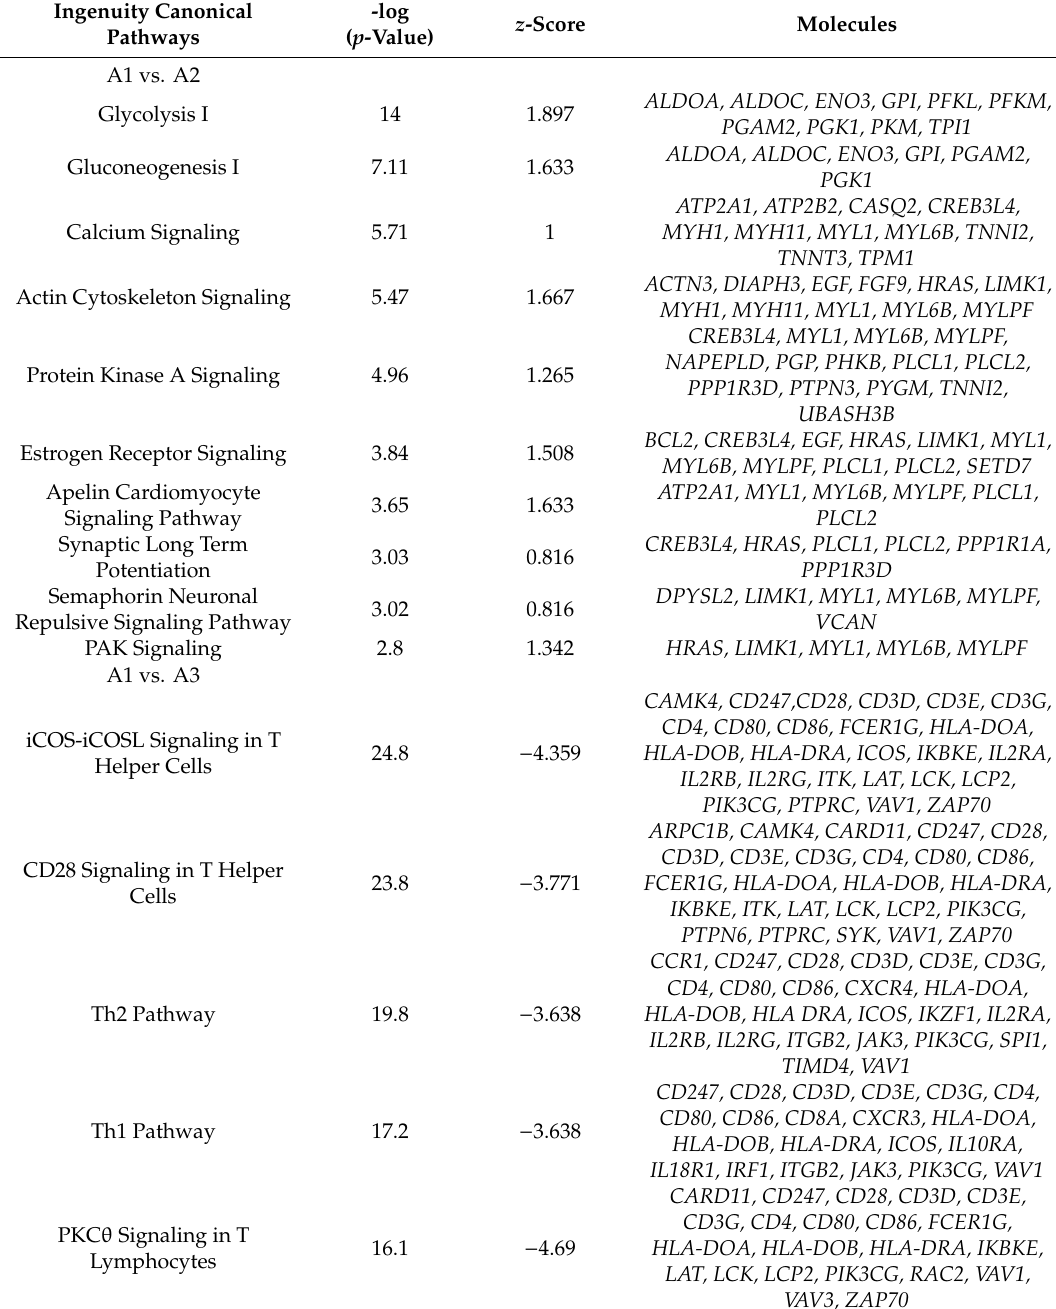
Table 2. Top 10 IPA canonical pathways in group